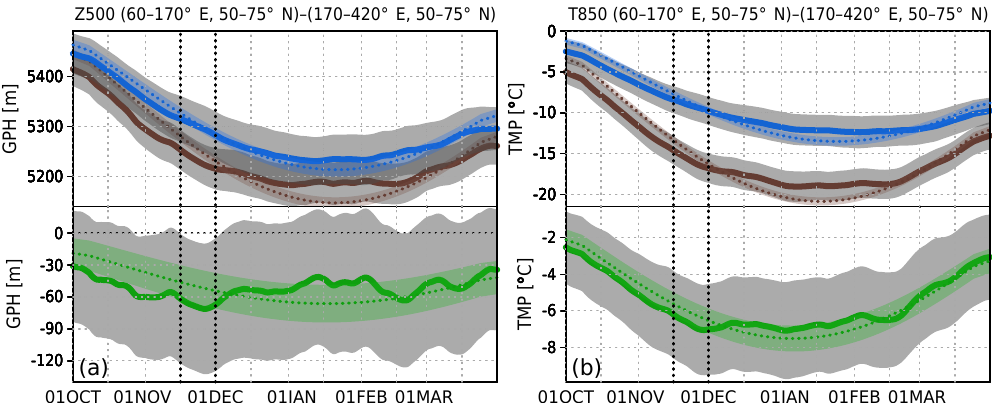
Figure 5. Time series of the climatological 15-day running mean (a) Z 500 (m) and (b) T 850 ( ◦ C) over Siberia (60–170 ◦ E, 50–75 ◦ N; brown lines), outside Siberia (170 ◦ E–60 ◦ W, 50–75 ◦ N; blue lines), and their anomalies within Siberia from their values outside of Siberia (green lines) from 1 October through 31 March. The dotted lines are sinusoidal lines, and color shadings indicate a 95% confidence interval. The vertical black dotted lines indicate the period of the late November short